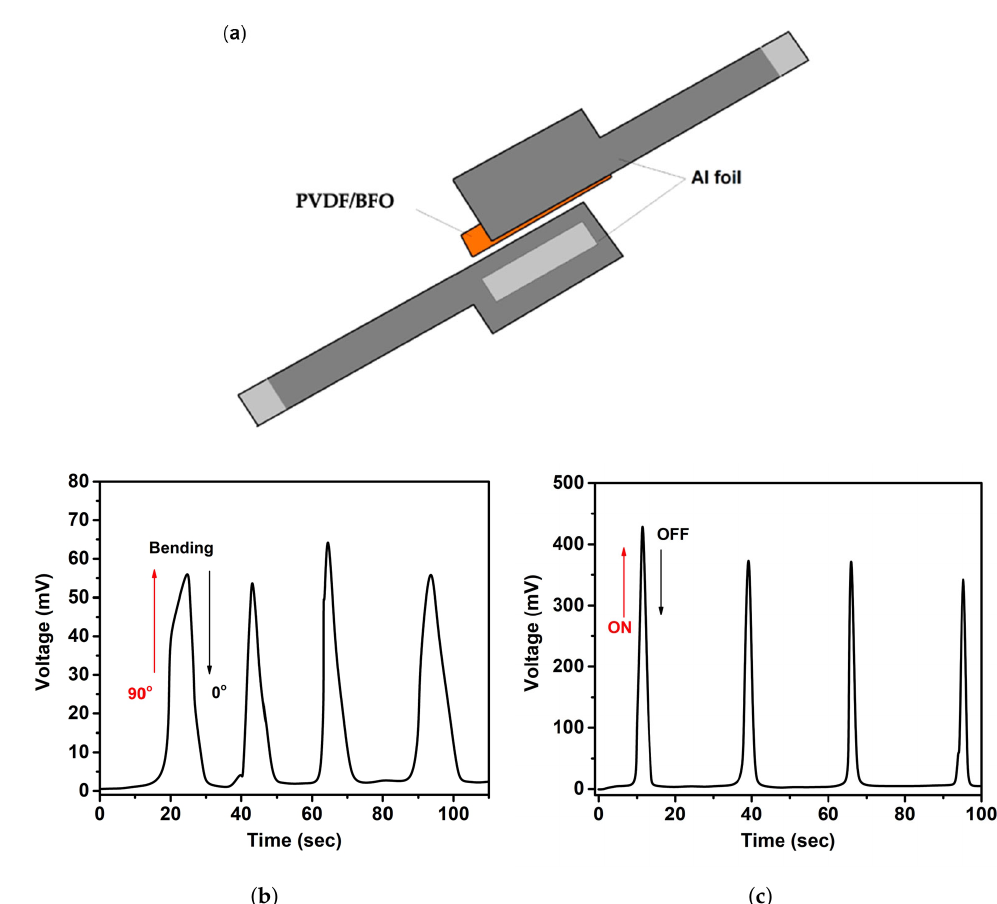
Figure 8. ( a ) Schematic structure of the PVDF/BFO-based PENG. ( b ) The PVDF/BFO-based PENG time-dependent open-circuit voltages under 90° bending and ( c ) US